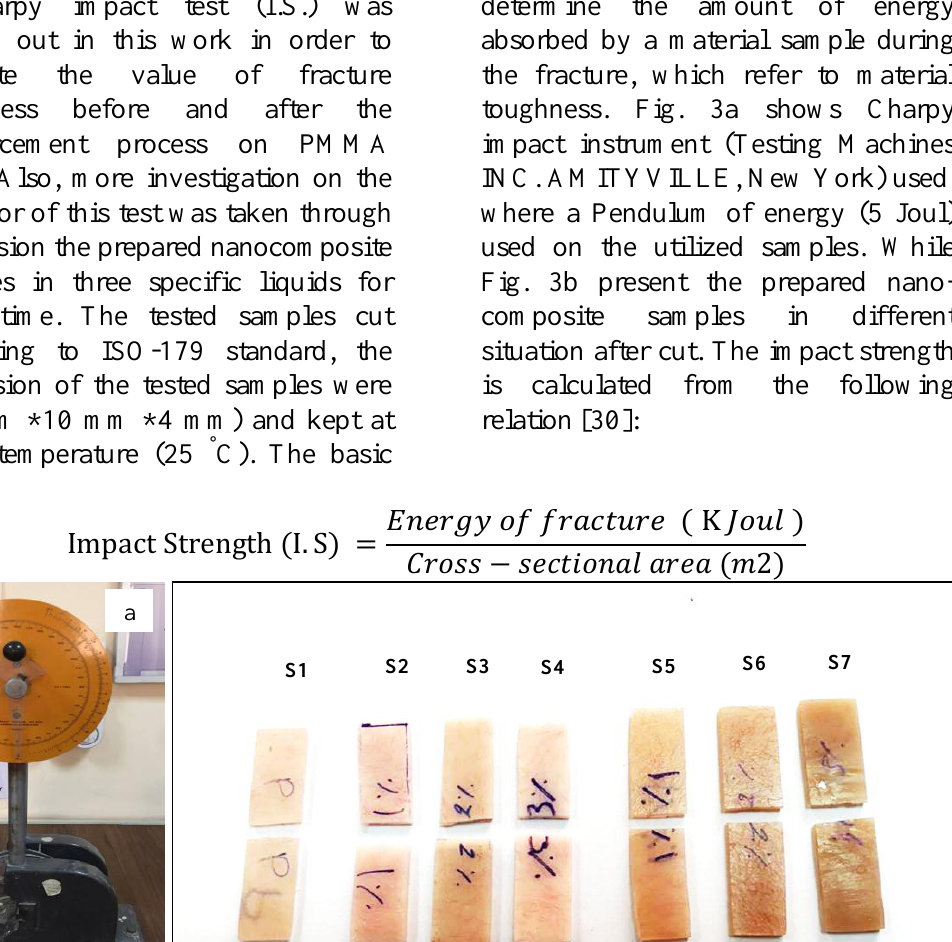
Fig.2: The casting specimens for PMMA composite reinforced by (Al Peel) particles respectively before test.